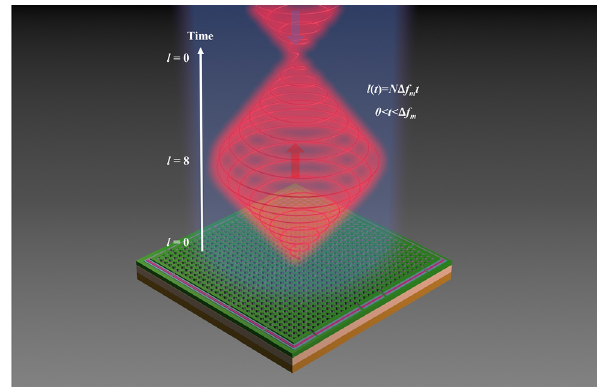
Figure 1: The schematic demonstration of a time-varying optical vortex generated by reflection of laser beam from a time modulated metasurface with an azimuthal frequency gradient. The beam is characterized by a ring-shaped intensity pattern whose radius in- creases and decreases continuously and periodically in time due to the variations in the topological